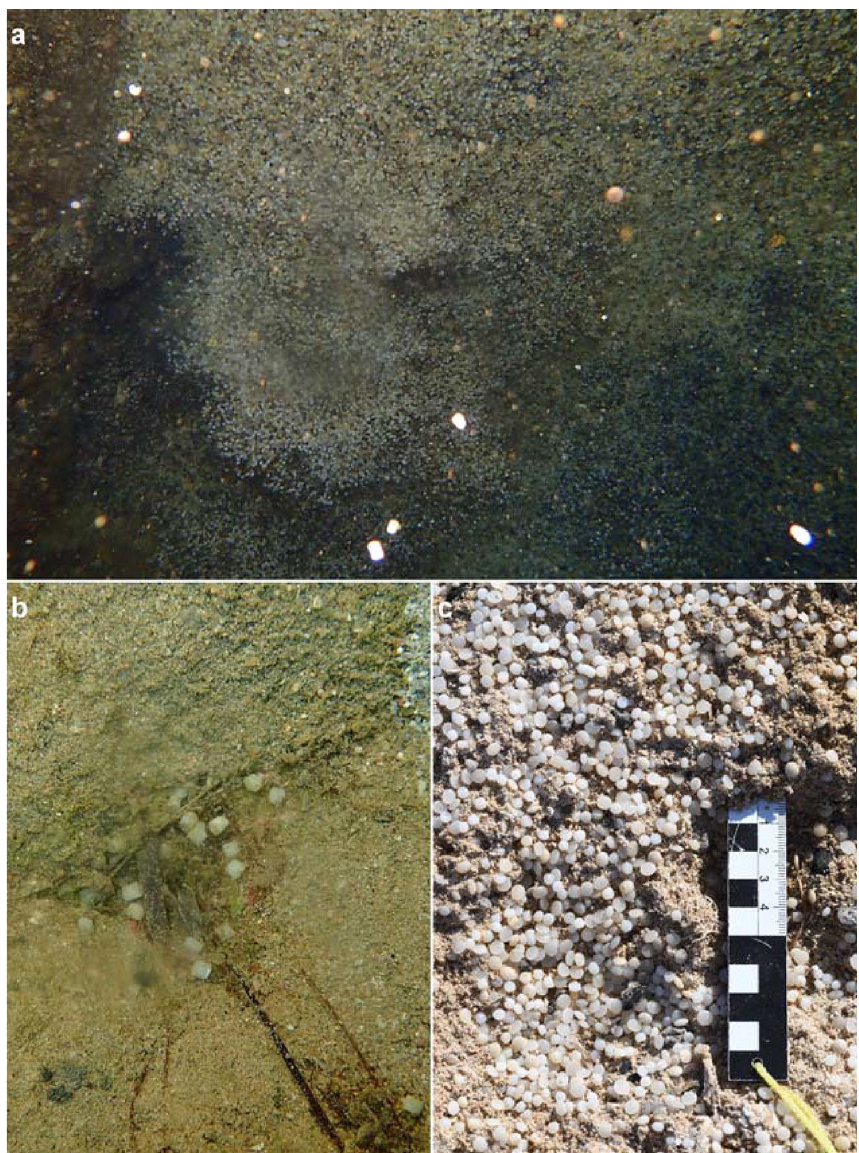
Figure 1. Fate of MP resin pellets from a beach in the Wadi el Gemal national park, Egypt, and the SS Hamada wreck in the Red Sea. ( a ) In the dark waters of the ship wreck, thousands of pellets floating up and down. ( b ) While some sacks fell off the ship and released fouled plastics to the surrounding sea floor after they have been torn open, other parts of the load ( c ) floated to the sea surface, from which they drifted to a nearby beach, which act as a highly covered plastic